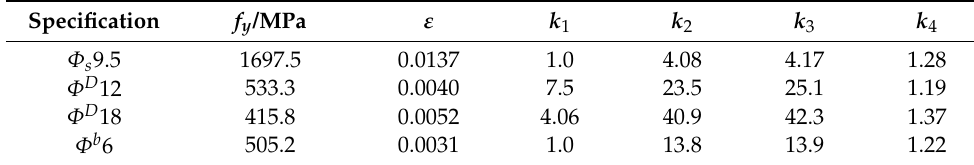
Table 4. Material parameters of reinforcement model.